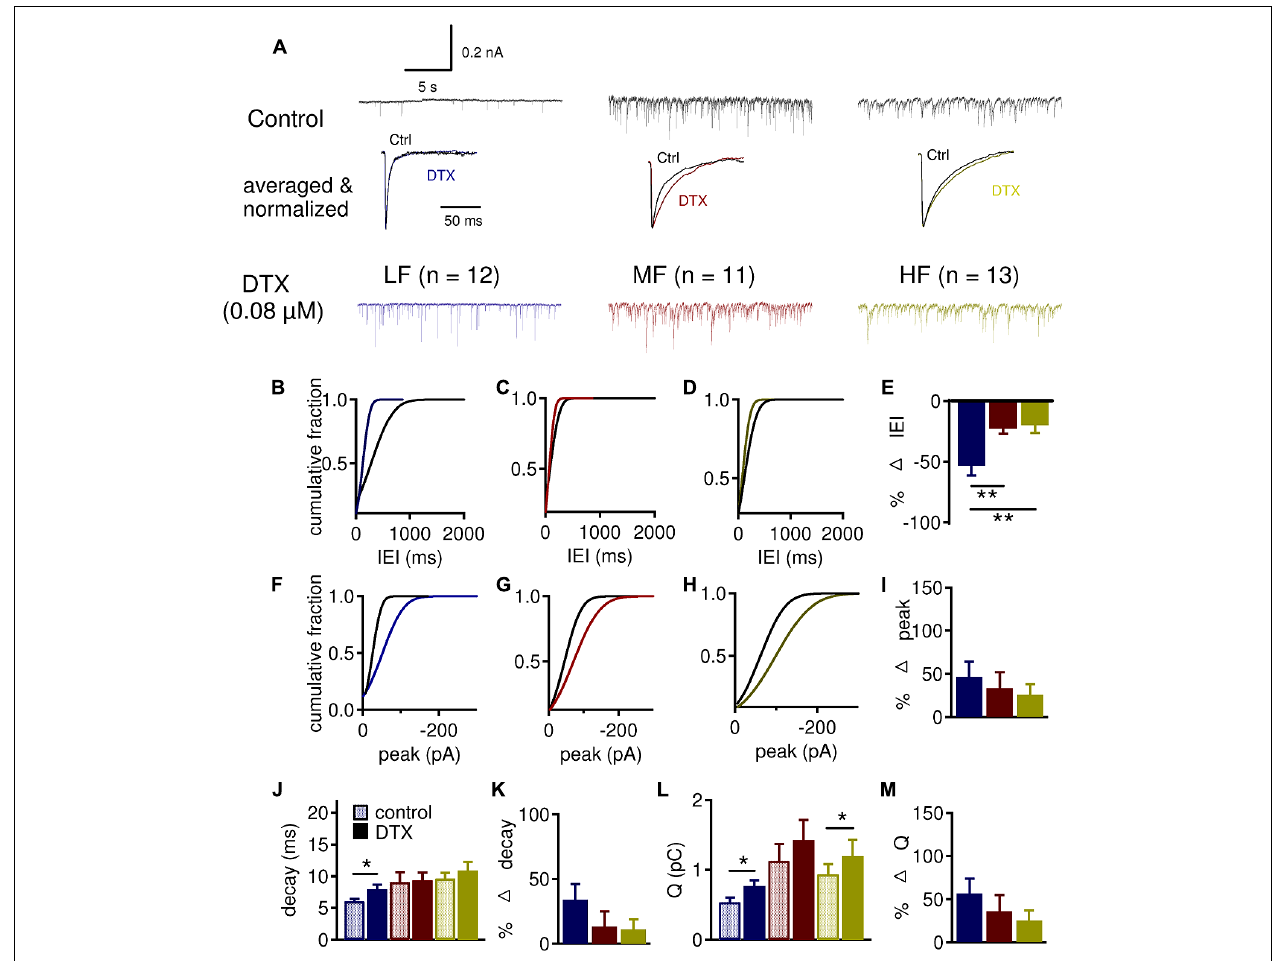
FIGURE 9 | LTK currents strongly regulate the frequency of sIPSCs in LF neurons. (A) Sample sIPSC recordings before (dark traces) and after (color traces) bath application of DXT (0.08 μ M) in LF (blue, n = 12), MF (red, n = 11) and HF (yellow, n = 13) NL neurons. See Figure 6A for legend. (B–D) Cumulative fraction of IEI in LF (B) , MF (C) , and HF (D) neurons before (black) and after (color) DTX. (E) Percent change in IEI is significantly larger in LF ( − 53.1 ± 8.3%) neurons compared to MF ( − 22.7 ± 4.2%) and HF ( − 19.8 ± 6.4%) neurons. No differences were observed between MF and HF neurons. (F–H) Cumulative fraction of sIPSC IEI in LF (F) , MF (G) , and HF (H) neurons before (black) and after (color) DTX. (I) No significant differences in percent change in sIPSC peak after DTX treatment between LF